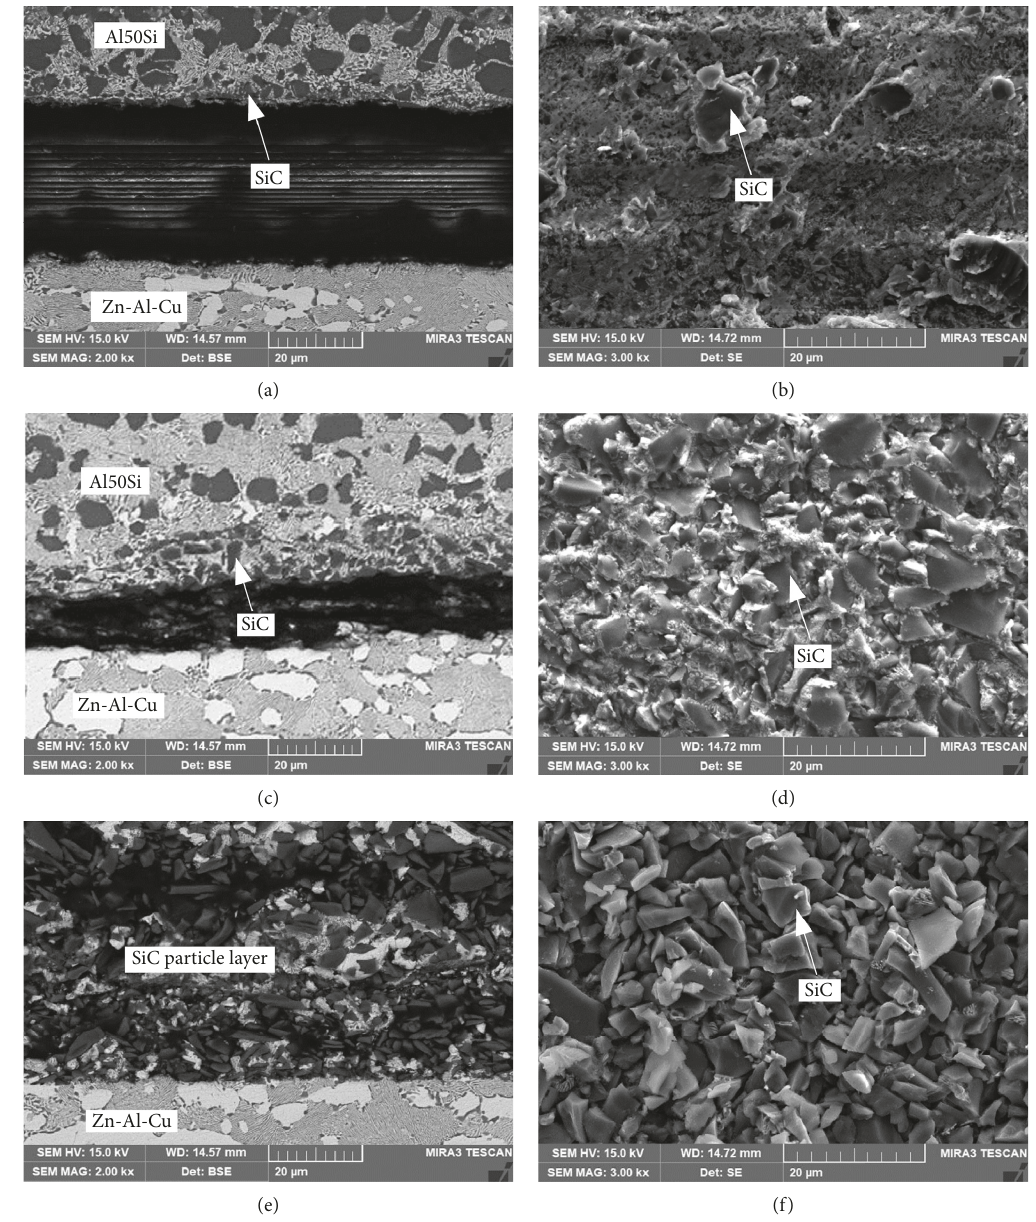
Figure 8: Fracture path and fracture surface of the joint with 1 μ m SiC particles at (a) and (b) 3g/m 2 , (c) and (d) 16g/m 2 , (e) and (f) 32 g/m 2